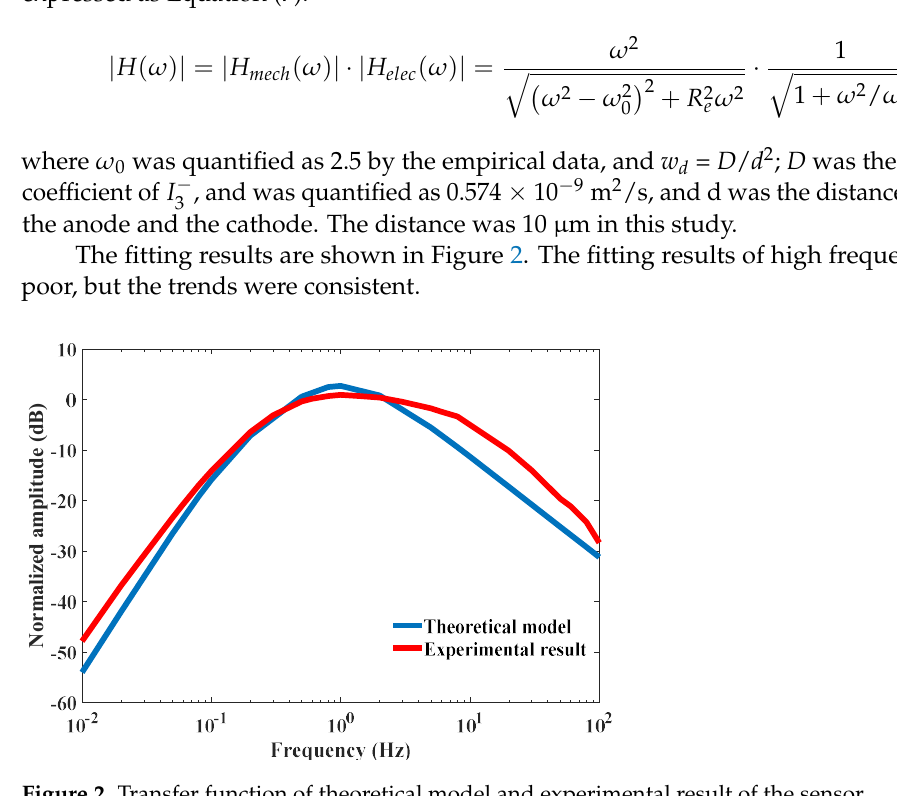
Figure 2. Transfer function of theoretical model and experimental result of the sensor.